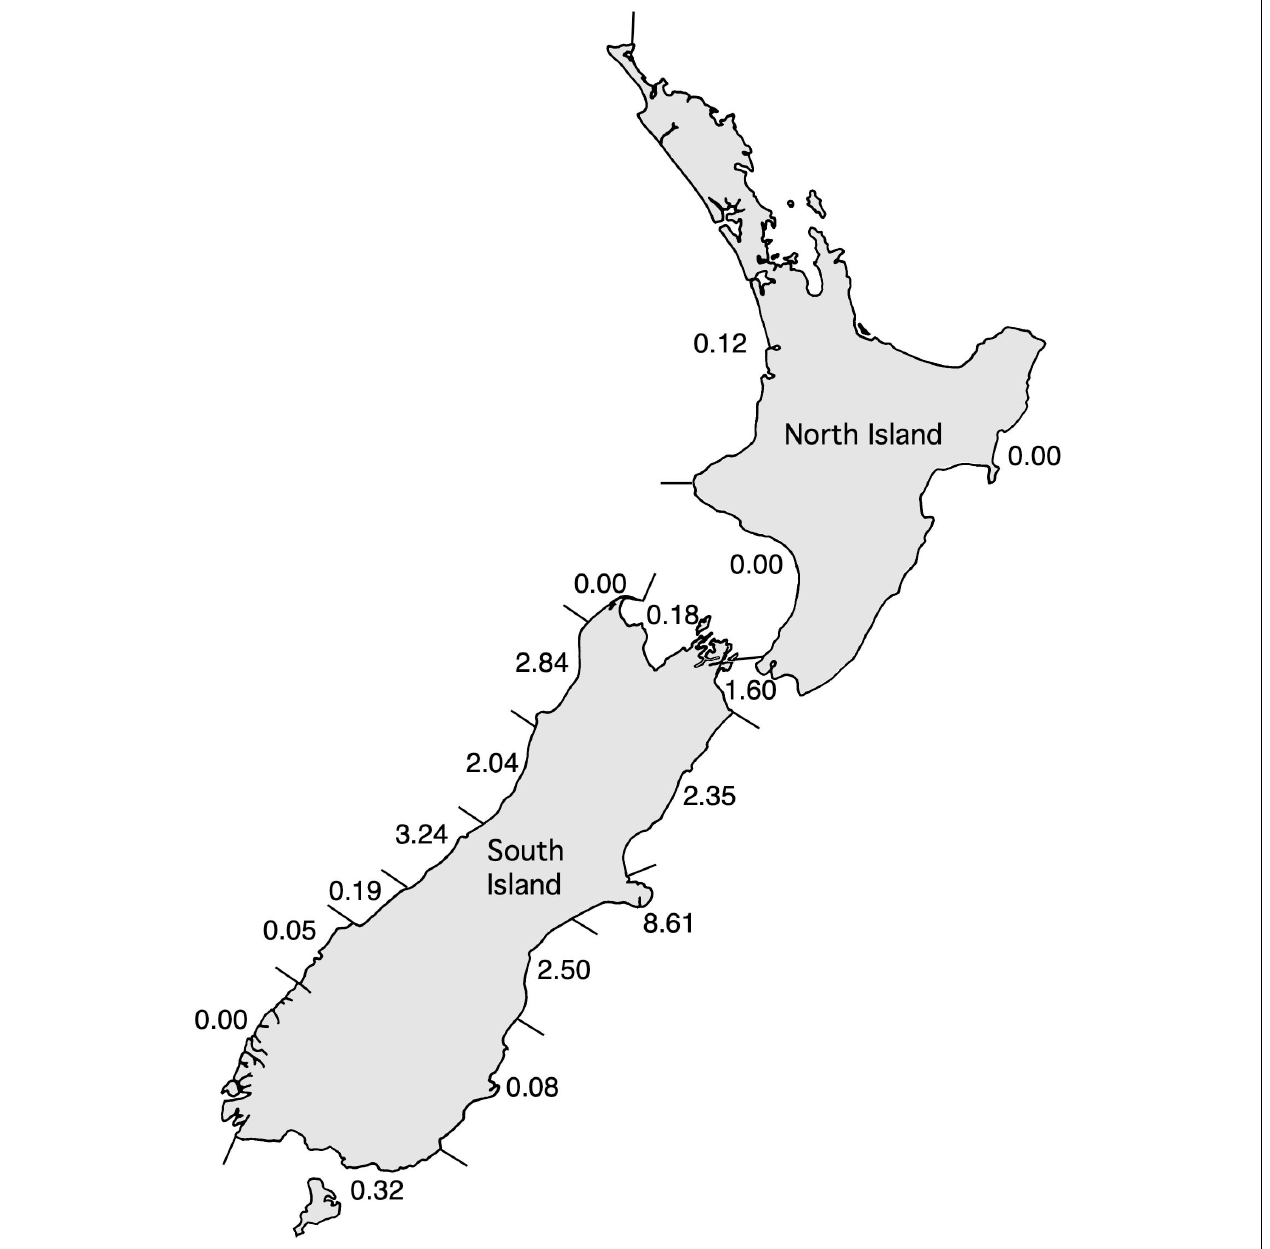
FIGURE 1 | Map showing PBR estimates for regional populations of M¯aui dolphins (North Island) and Hector’s dolphins (South Island), using the most recent population estimates, and default values of 0.04 for Rmax and 0.1 for recovery factor.